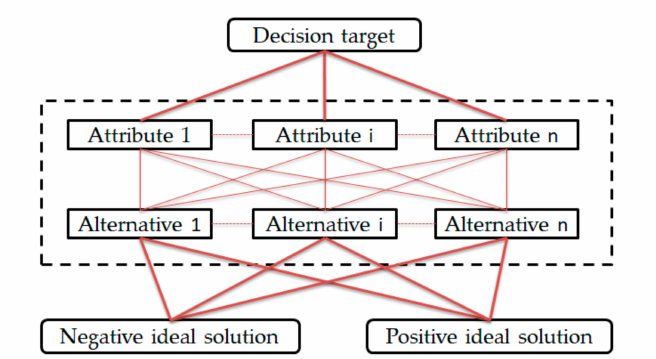
Figure 5. The classify diagram of the technique for order of preference by similarity to an ideal solution (TOPSIS)